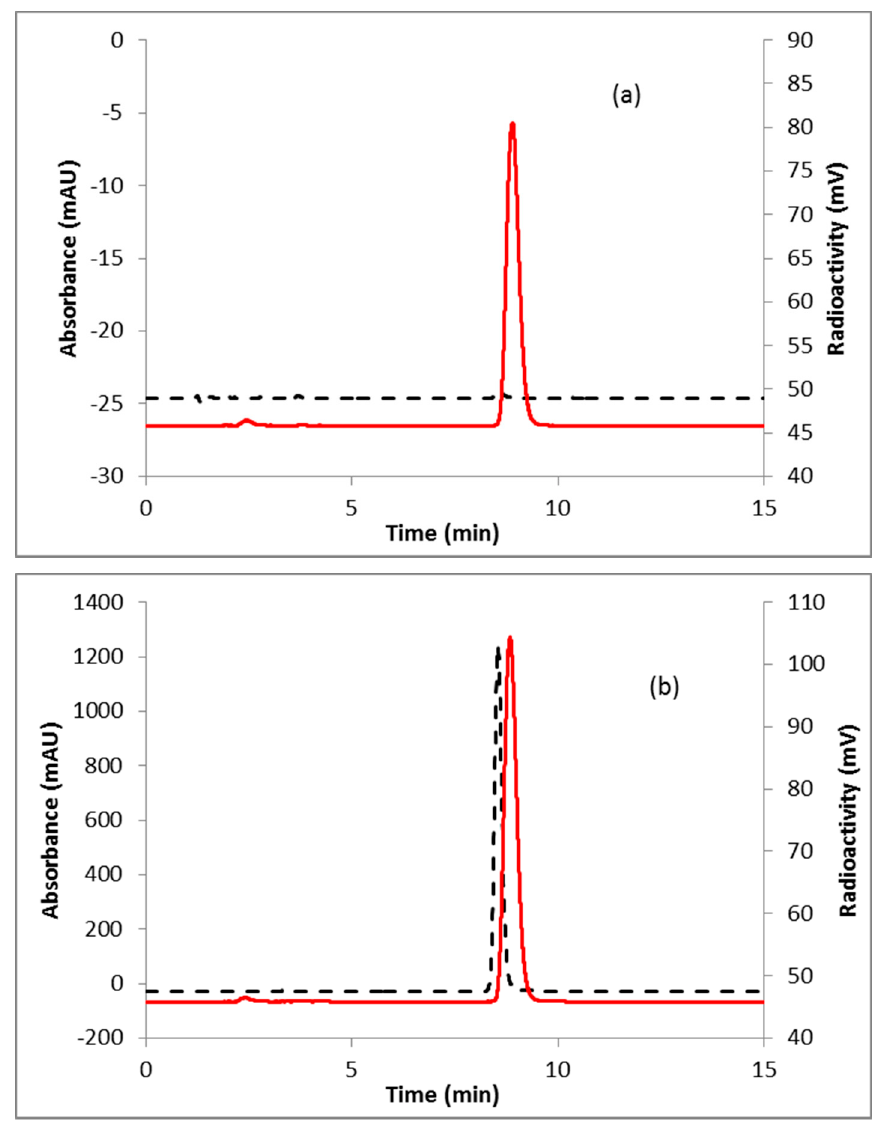
Figure 3. HPLC analysis (method A) of pure ( a ) [ 18 F]FFNP; ( b ) [ 18 F]FFNP, co-injected with the non-radioactive standard. Solid line, in-line radiodetector; dotted line, UV detector at 254 nm.